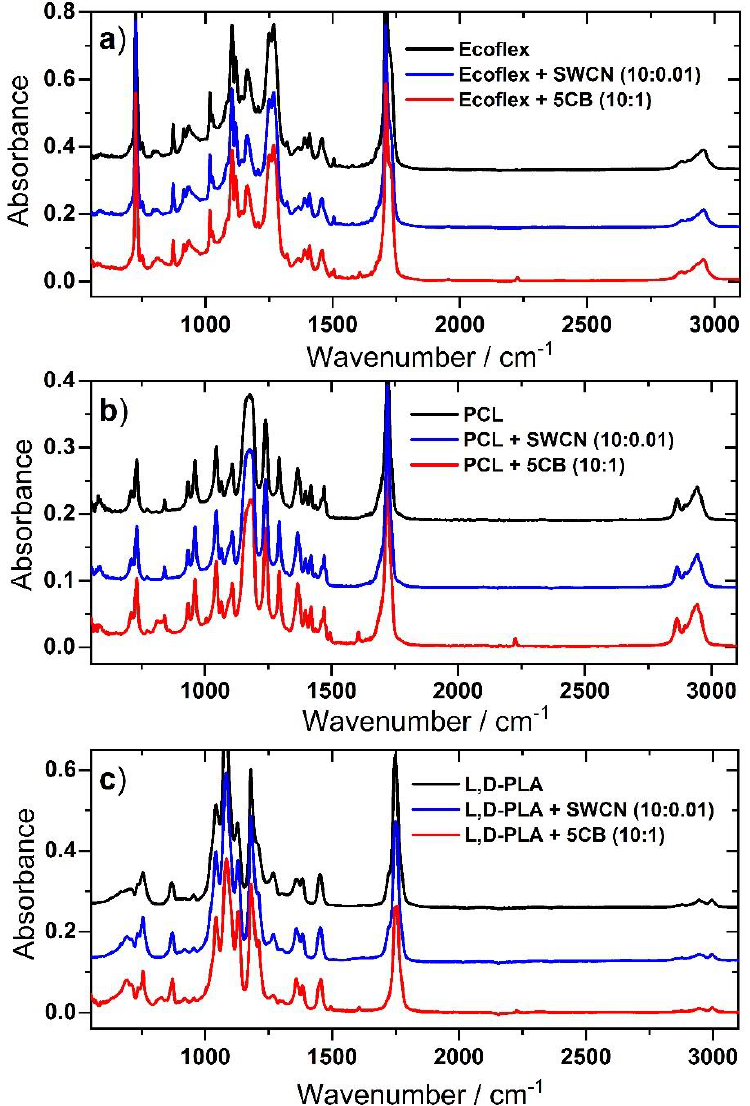
Figure 11. Comparison of FTIR spectra of Ecoflex ® ( a ), PCL ( b ), and L,D-PLA ( c ) layers without and with the addition of SWCN or 5CB.